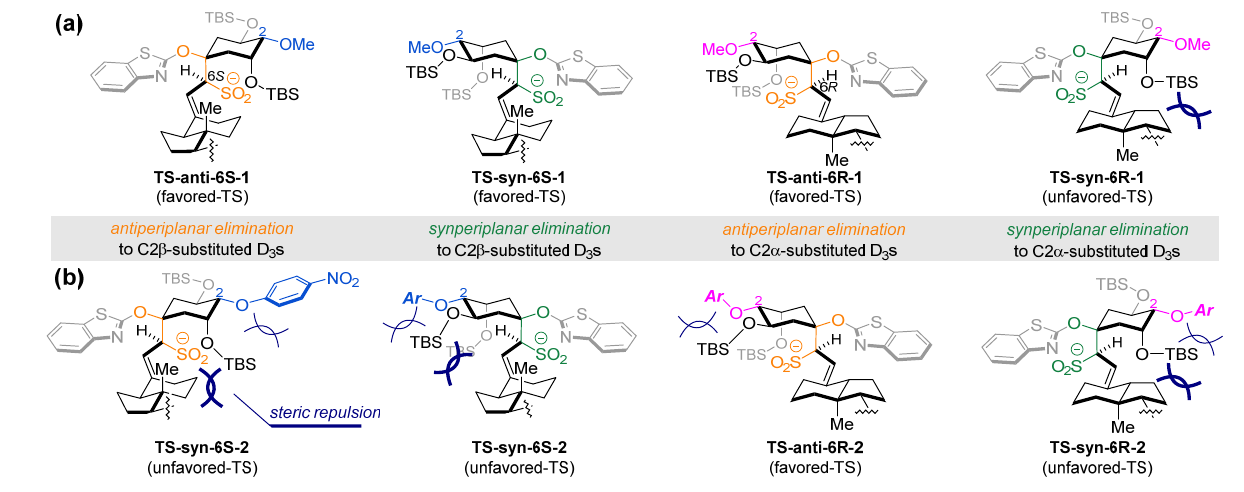
Figure 2. Possible transition states for the Julia-type olefination with 5a ( a ) and 5c ( b ).